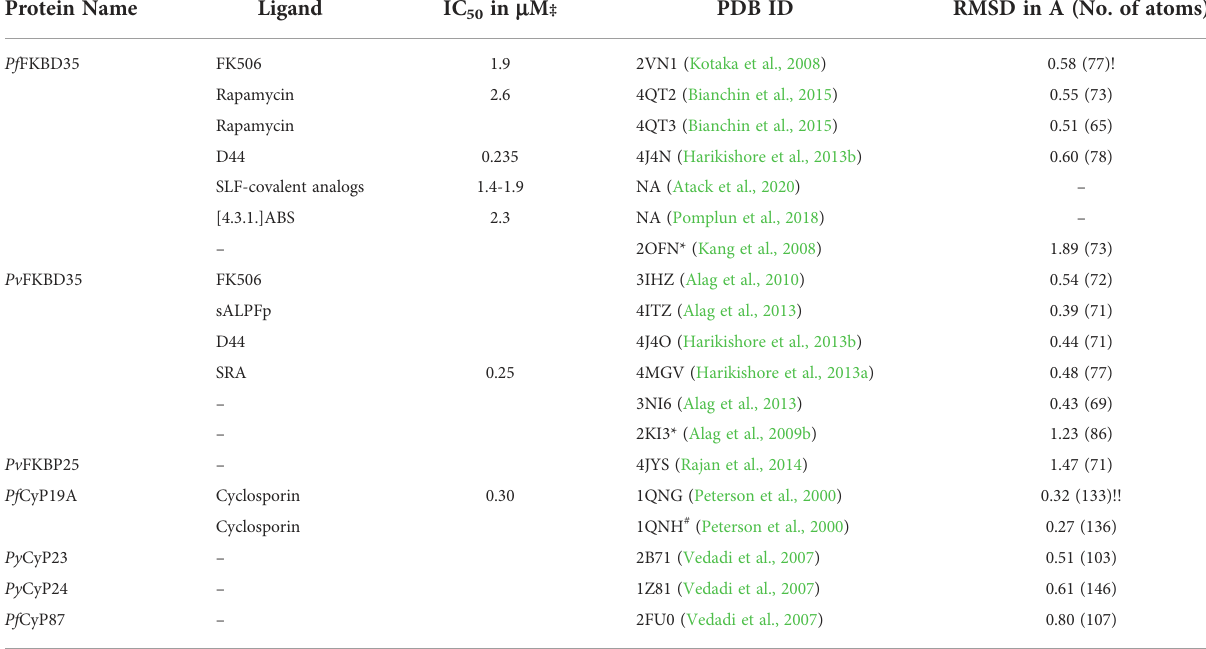
TABLE 1 List of Plasmodium PPIases, their inhibitors, IC 50, and PDB ID, if available. Protein